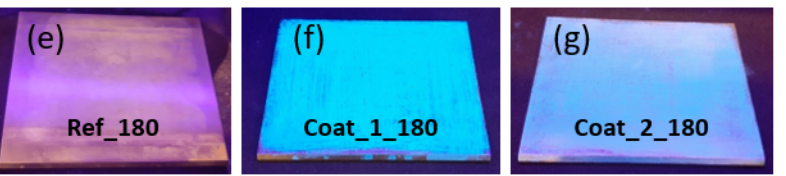
Figure 8. Images of uncoated and coated Si wafers and steel plates under UV irradiation ( λ = 365 nm); top row: ( a ) uncoated Si wafer, ( b ) ref_180, ( c ) coat_1_180 and ( d ) coat_2_180 on Si wafers; bottom row: ( e ) ref_180, ( f ) coat_1_180 and ( g ) coat_2_180 on steel plates.